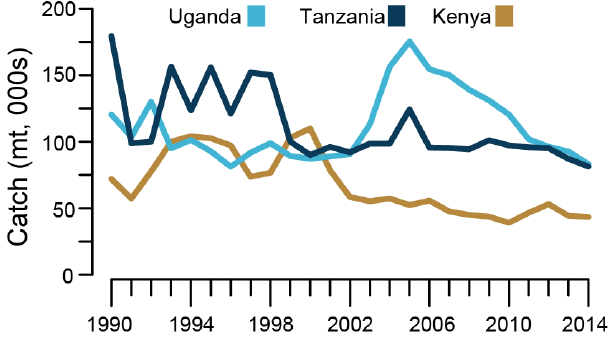
Fig. 7 . Trends in catch of Nile perch and tilapia in Uganda, Kenya, and Tanzania. Catch in Uganda trended sharply upward from 2003 through 2007, corresponding in time to the most violent conflict in northern Uganda. Catch in Kenya and Tanzania declined during this period.